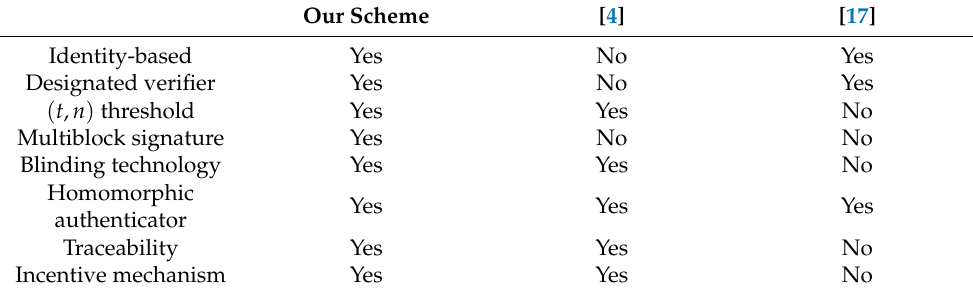
Table 2. Functionality